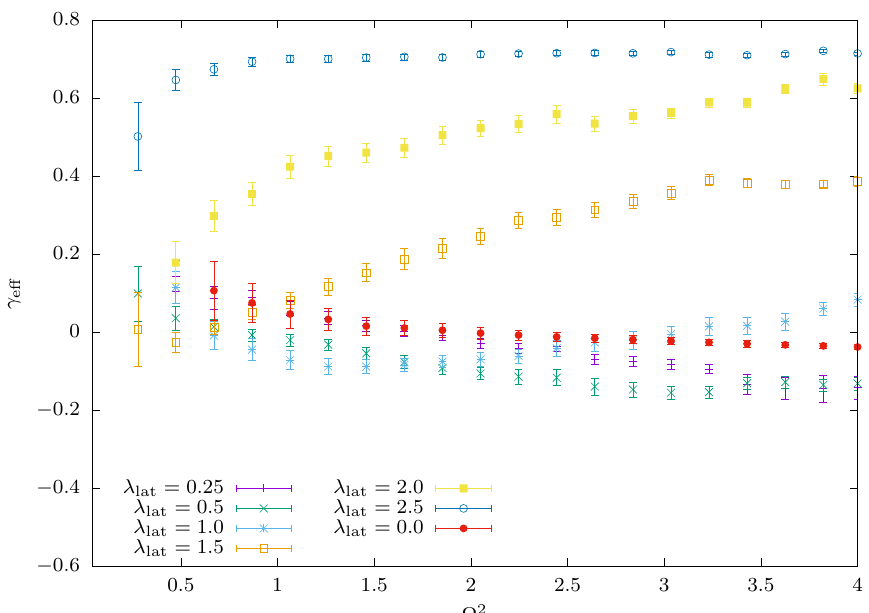
Figure 7. Effective anomalous dimension γ eff obtained from using eq. (3.3) to fit the stochastic Chebyshev mode number across the window [0 , Ω 2 ] , for 16 4 lattices with gauge group U(2). Results from fitting the analytic free-theory mode number are included for comparison. The errorbars are dominated by the standard fit error, and we omit results from fits that produce errors larger than 0 . 1